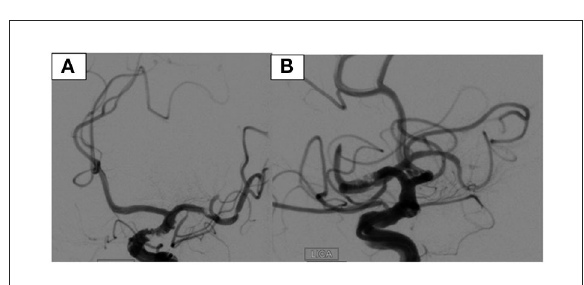
following the procedure. The patient was then transferred to the neurological ICU intubated and